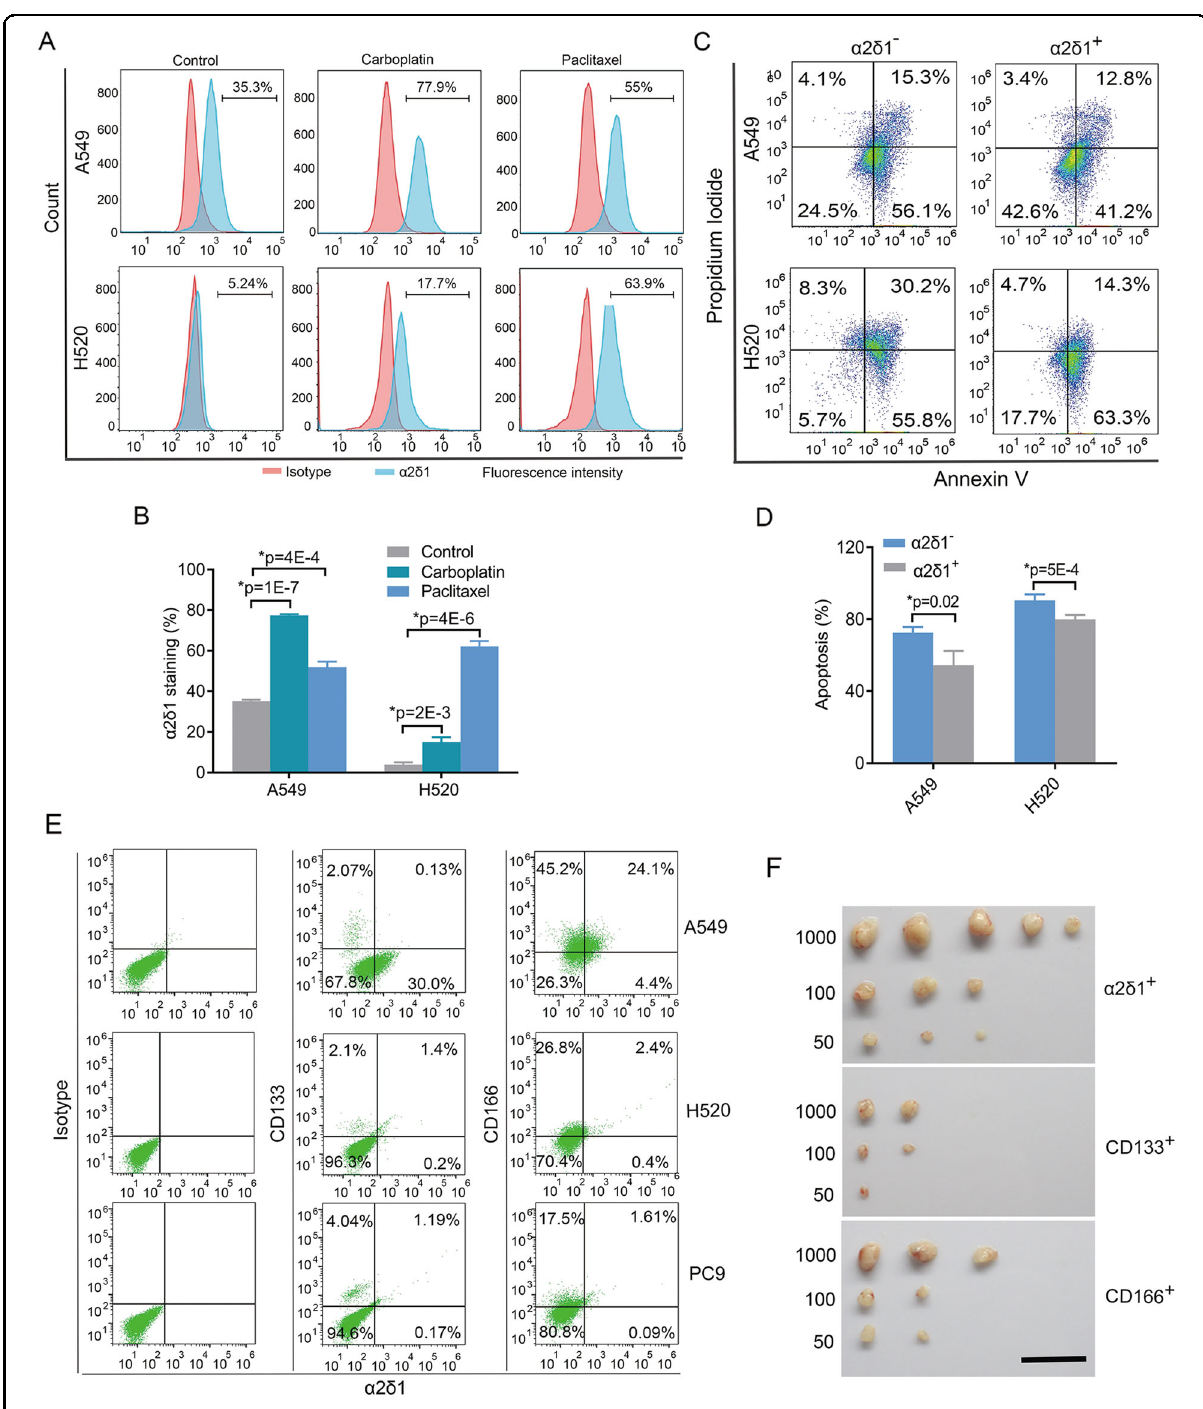
Fig. 3 Characterization of α 2 δ 1 + TICs of NSCLC. A Representative fl ow cytometry analysis of α 2 δ 1 + fractions following carboplatin (10 µmol/L) and paclitaxel (1 nmol/L) treatment for 96 h. B Histograms showing the change of the percentage of α 2 δ 1 + cells after carboplatin and paclitaxel treatment. C Representative fl ow cytometry analysis of the apoptosis of both the α 2 δ 1 + and α 2 δ 1 – cells from indicated sources after carboplatin treatment for 48 h at 10 µ mol/L as measured by fl ow cytometry. D Histograms showing the percentage of apoptotic cells of indicated subsets upon carboplatin treatment. E The relationship of the expression of α 2 δ 1 with CD133 and CD166 as detected by fl ow cytometry in the indicated NSCLC cell lines. F Side-by-side comparison of the tumorigenic potential of α 2 δ 1 + cells with that of CD133 + and CD166 + A549 cells by limited dilution transplantation into NOD/SCID mice ( n = 5 for each group). Scale bar, 2 cm. The error bars in ( B ) and ( D ) represent SD of three independent experiments. *Student ’ s t-test